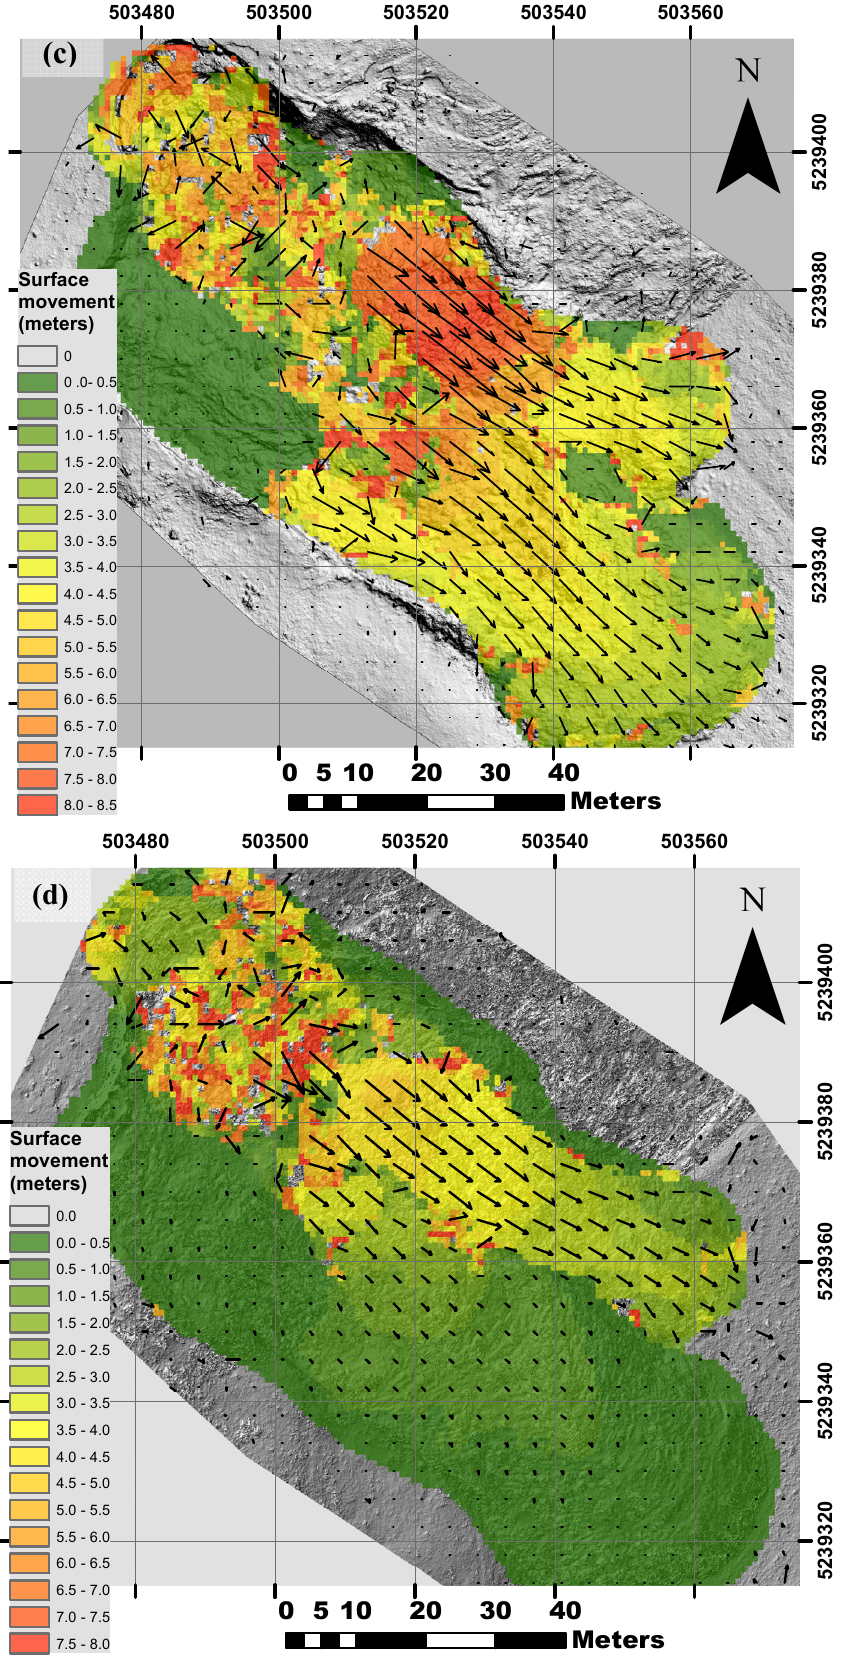
Figure 6. Cosi-Corr surface movement maps; ( a ) 2011B–2012A; ( b ) 2012A–2013A; ( c ) 2013A–2013B; and ( d ) 2013B–2014A (coordinate system: GDA94